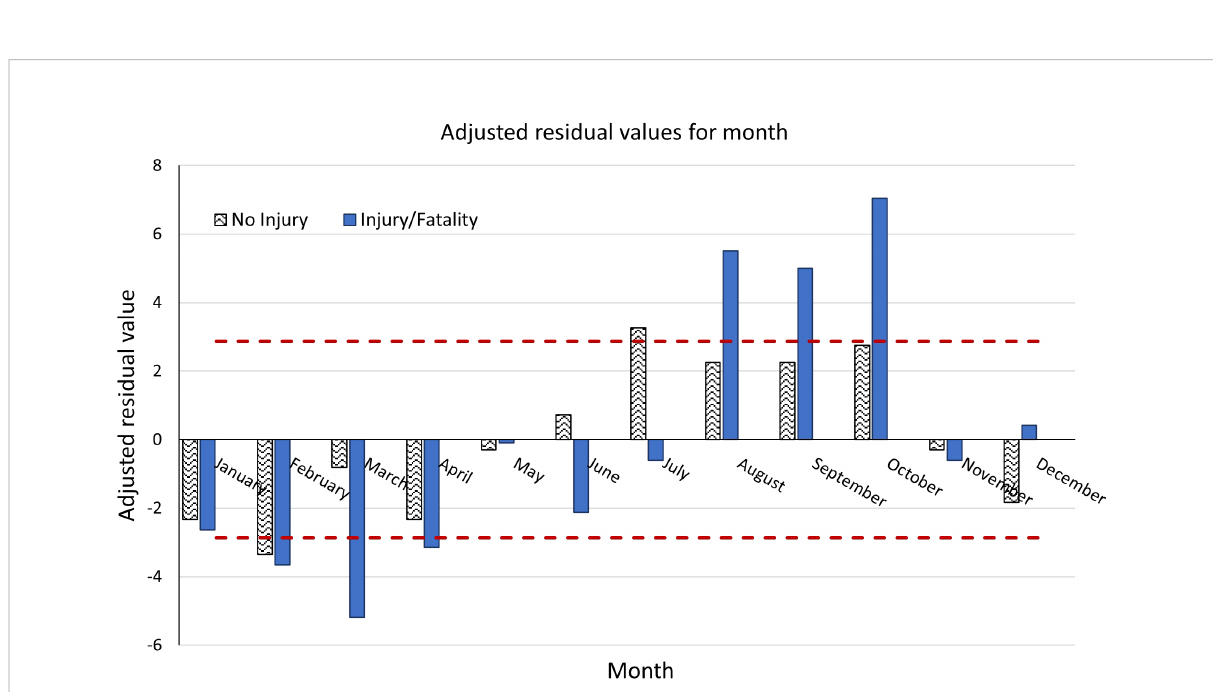
FIGURE 5 Adjusted residual values showing the direction and magnitude of difference between expected and documented number of shark incidents for all species by month, split by no injury and injury/fatality. The horizontal dashed red lines represent the cutoff for 95% signi fi cance. Bars that do not extend past the red horizontal dashed lines represent values that did not statistically differ from the expected count when analyzed with a Chi-squared test. Injury categories were tested separately but are presented together.